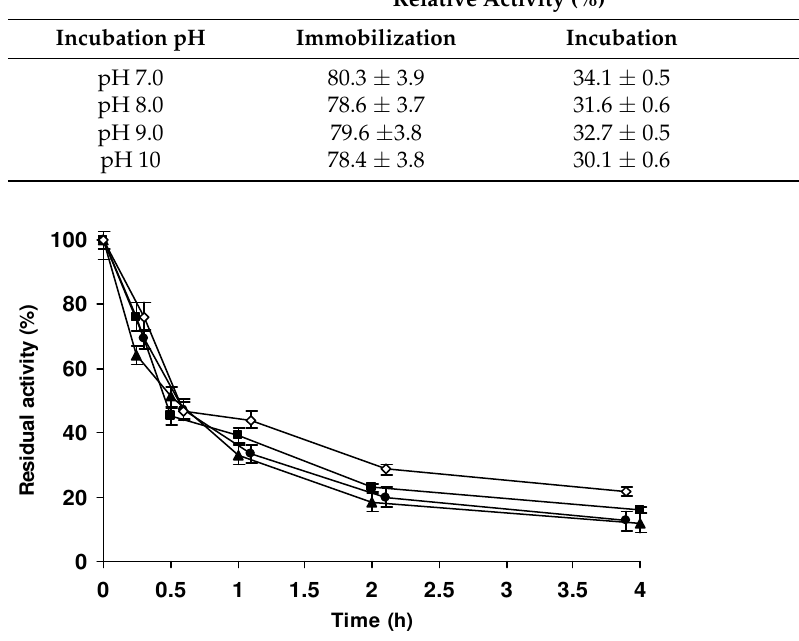
Figure 5. Effect of the incubation pH of the PGA biocatalyst on its thermal stability. Figure shows the thermal inactivation courses of PGA immobilized at pH 7 and incubated at different pH values (see legend of Table 3). Full triangles: pH 7.0. Full circles: pH 8.0. Full squares: pH 9.0. Empty rhombi: pH 10.0. Other specifications are described in the Methods Section.